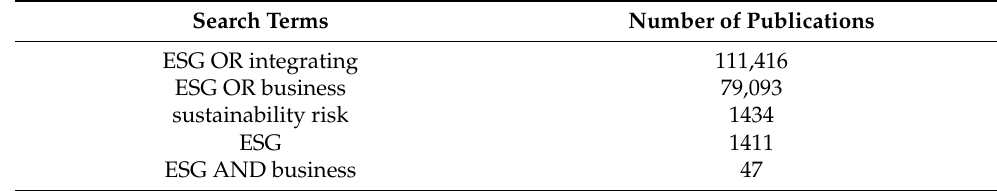
Table 1. Number of articles identified in the WoS and Scopus databases according to the selected keywords. Search Terms